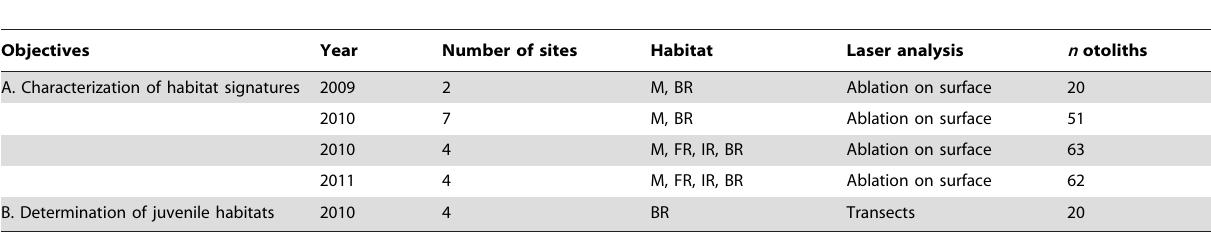
Table 1. Sampling design and chemical